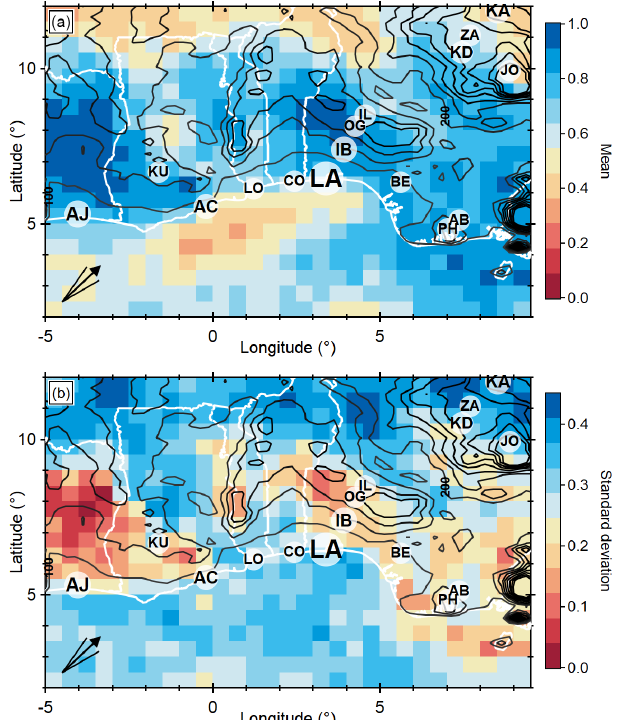
Figure 3. Mean and day-to-day standard deviation of low-level cloud fraction between 10:00 and 11:00UTC during the DACCIWA aircraft campaign, 29 June–16 July 2016, taken from the LLC flag derived from SEVIRI cloud data. The contours show the elevation of the land surface and are labelled in metres above mean sea level. Text markers show the locations and abbreviated names of large cities in the region, which are listed in Table 1. The text size gives a qualitative indication of the relative population of each city. The arrow markers in the bottom left show the median and quartiles of wind direction, measured inland below 1km between 10:00 and 11:00UTC.